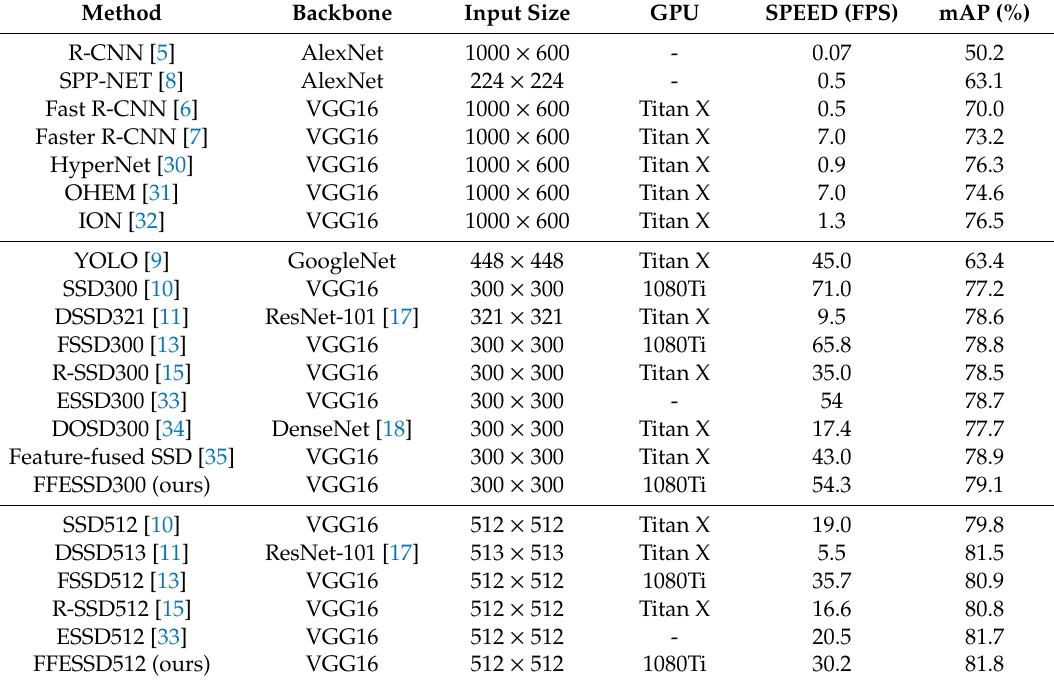
Table 1. Comparisons of speed and accuracy based on PASCAL VOC2007 tests. (For fair comparison, as introduced in Section 3, we have improved on the basis of SSD and only improved the network